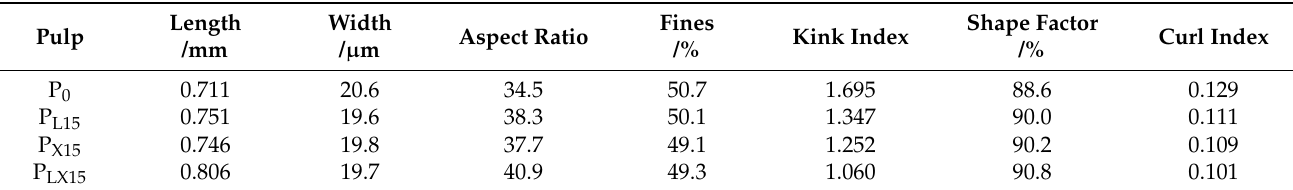
Table 1. Fiber characteristics of pulp before and after bio-enzyme